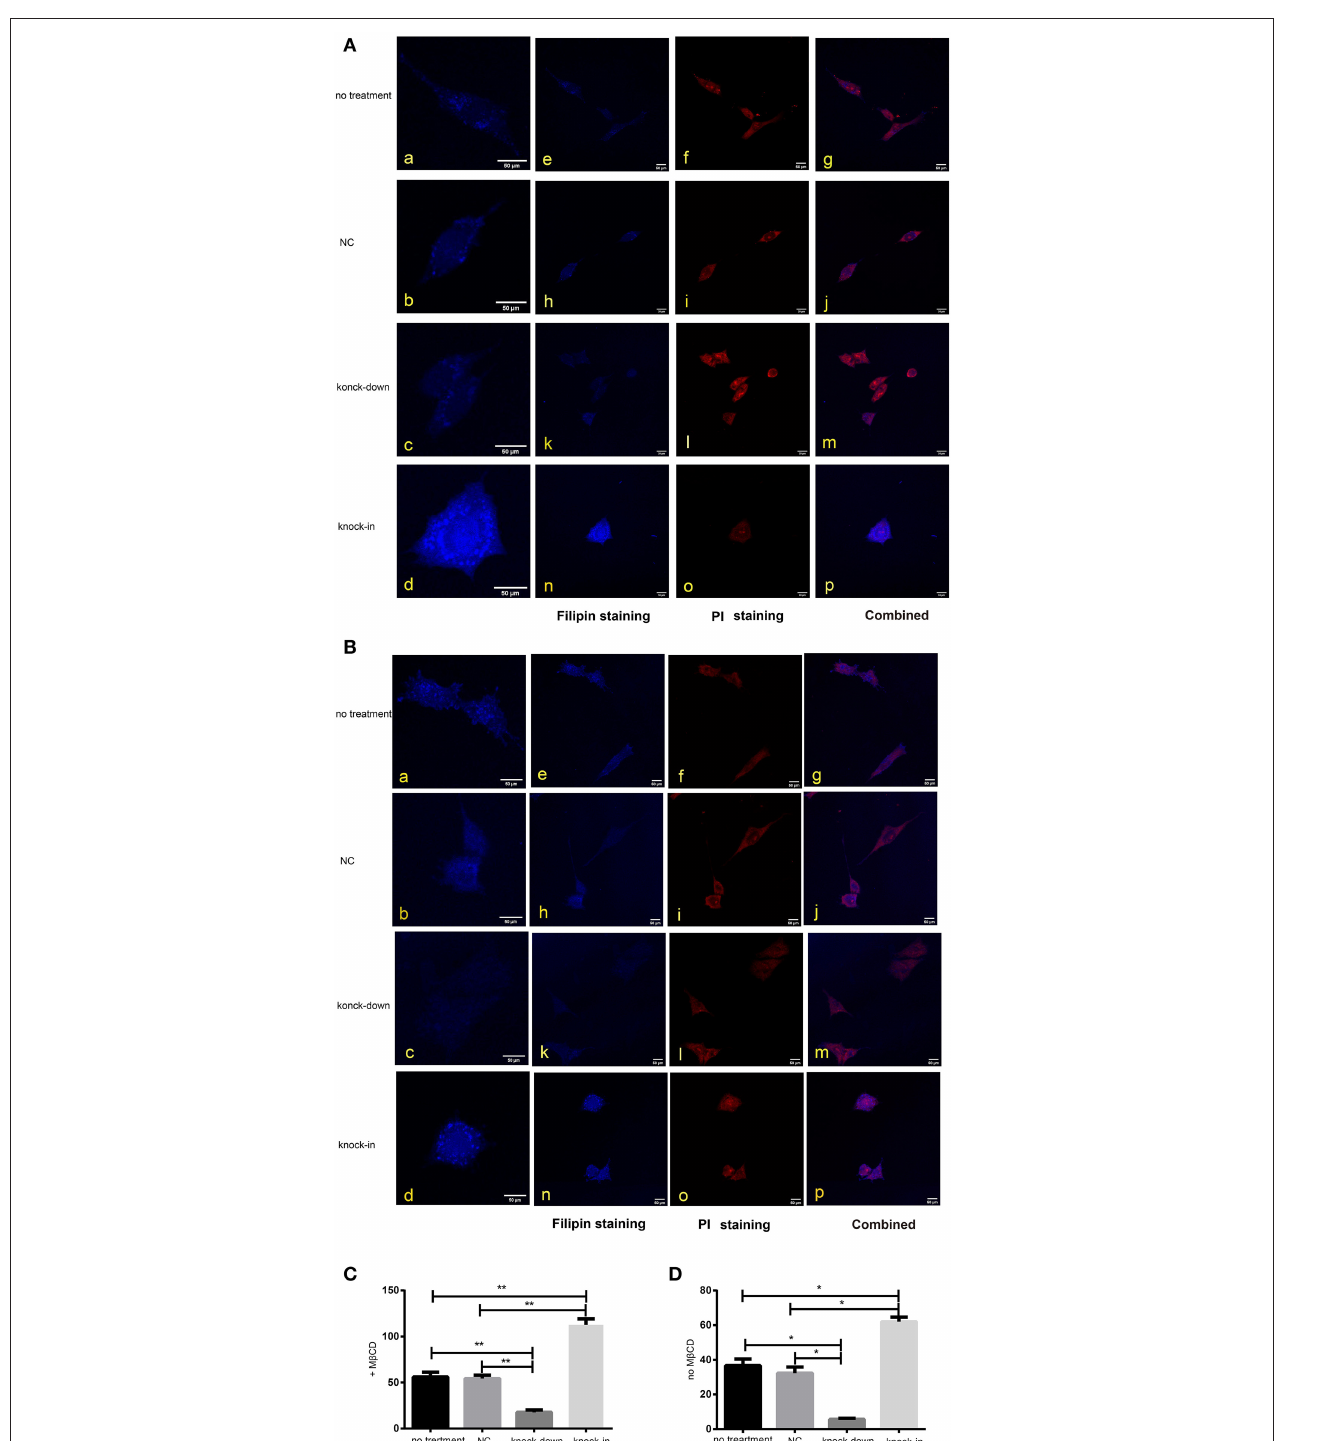
FIGURE 4 | DHCR24 knock-down lead to the decrease of plasma membrane and intracellular cholesterol level. Whole-cell and intracellular cholesterol stained with filipin. (A) Filipin stained cholesterol in the intracellular compartments. Cells were treated with M β CD (methyl- β -cyclodextrin) before fixation and filipin staining. The cells in blue were stained with filipin, and in red were stained with PI (propidium iodide), the final column shows a merged image of the two channels. (B) Whole-cell cholesterol staining with filipin on fixed SH-SY5Y cells. Filipin stains cholesterol in the plasma membrane and in intracellular compartments. Scale bar = 50 µ m. (a–d) of (A,B) were the zoomed picture of each group. Filipin intensity of cholesterol in the intracellular compartments (C) and cholesterol in whole-cell (D) were measured using Image J Software. All the data are presented as mean ± SD of at least three individual experiments ( n = 3). * P < 0.05, ** P < 0.01; vs. the no treatment and NC group.